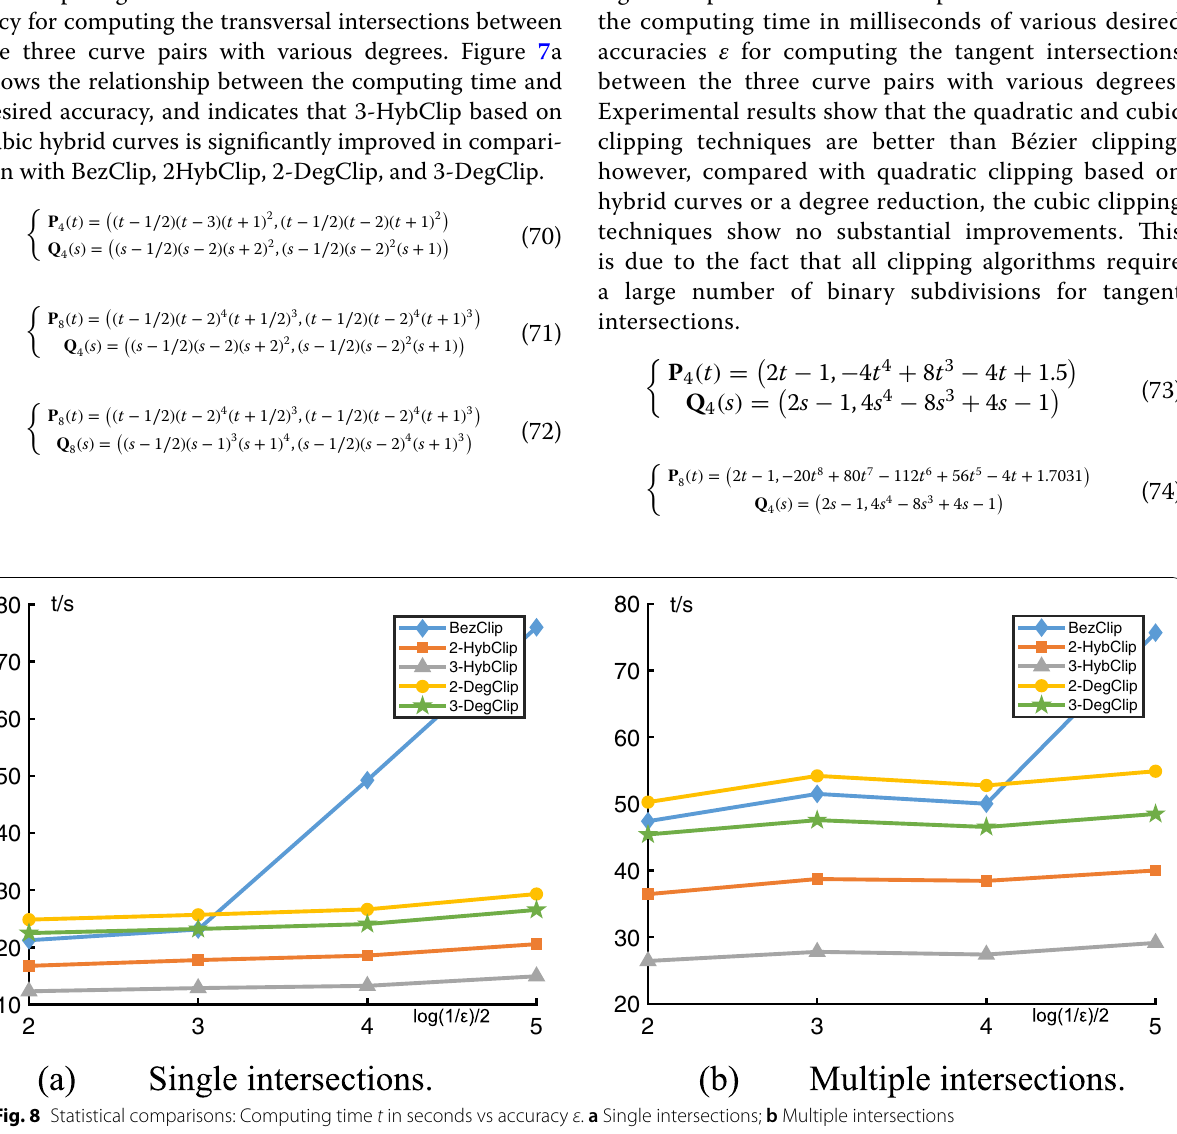
Fig. 8 Statistical comparisons: Computing time t in seconds vs accuracy ε . a Single intersections; b Multiple